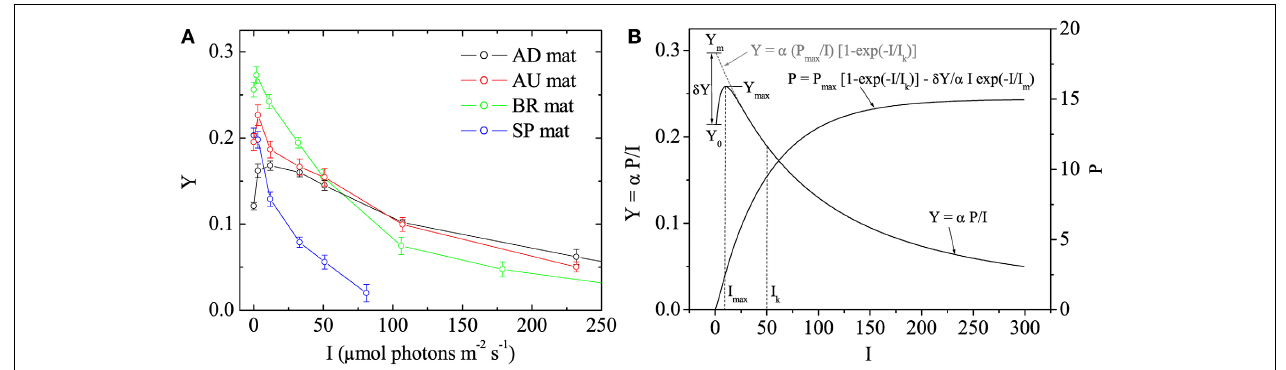
FIGURE 1 | (A) Examples of quantum yields of photosystem II, Y, in the studied cyanobacterial mats, as measured by pulse amplitude modulated (PAM) imaging at different irradiances, I . Symbols and error bars represent, respectively, the mean and SD calculated from 5 × 5